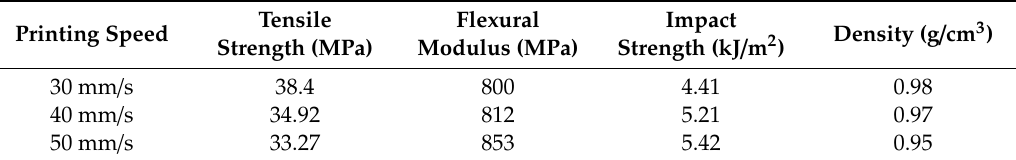
Table 2. E ff ect of printing speed on mechanical